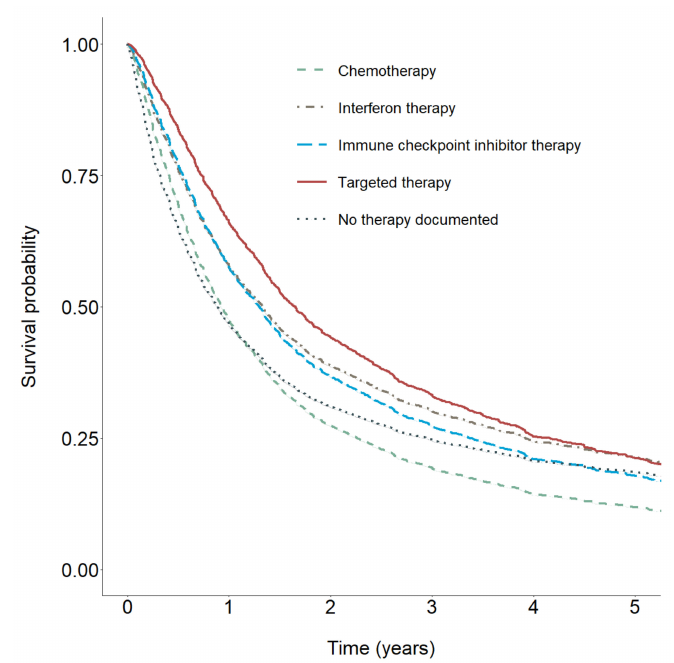
Figure 3. Predicted survivor functions (mean adjusted) for chemotherapy, interferon therapy, immune checkpoint inhibitor therapy, targeted therapy, and no documented